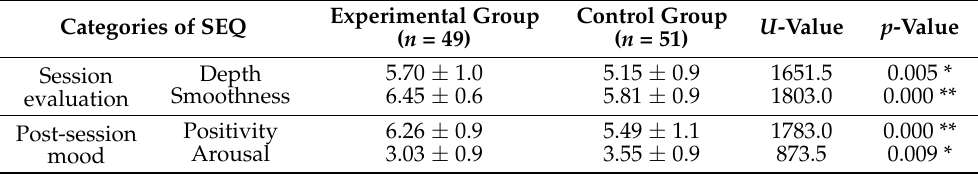
Table 2. Average SEQ scores for the experimental group and the control